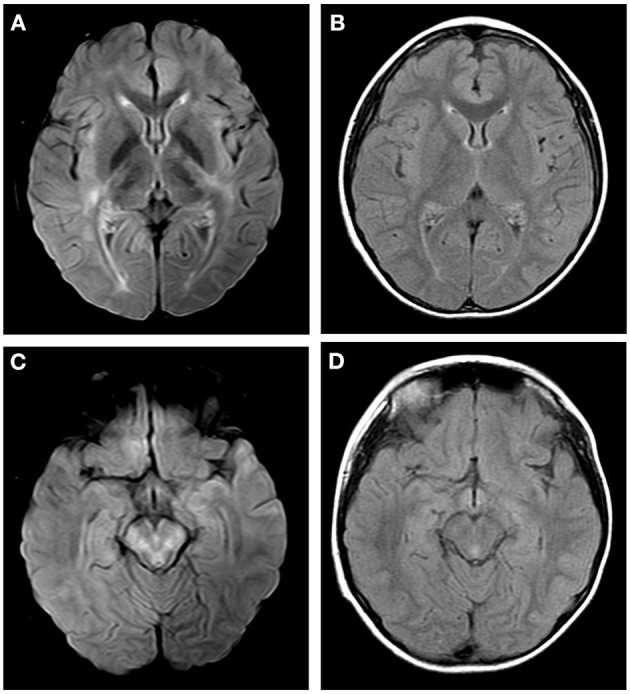
Axial fluid attenuation inversion recovery (FLAIR) MRI brain (A,C) 12 days after admission and (B,D) 1 month later. Image (A) showed T2-hyperintense lesions in internal capsule, hind limbs and external capsule. Image (C) showed T2-hyperintense lesions in brain stem. Follow-up images (B,D) showed improved T2 lesions.